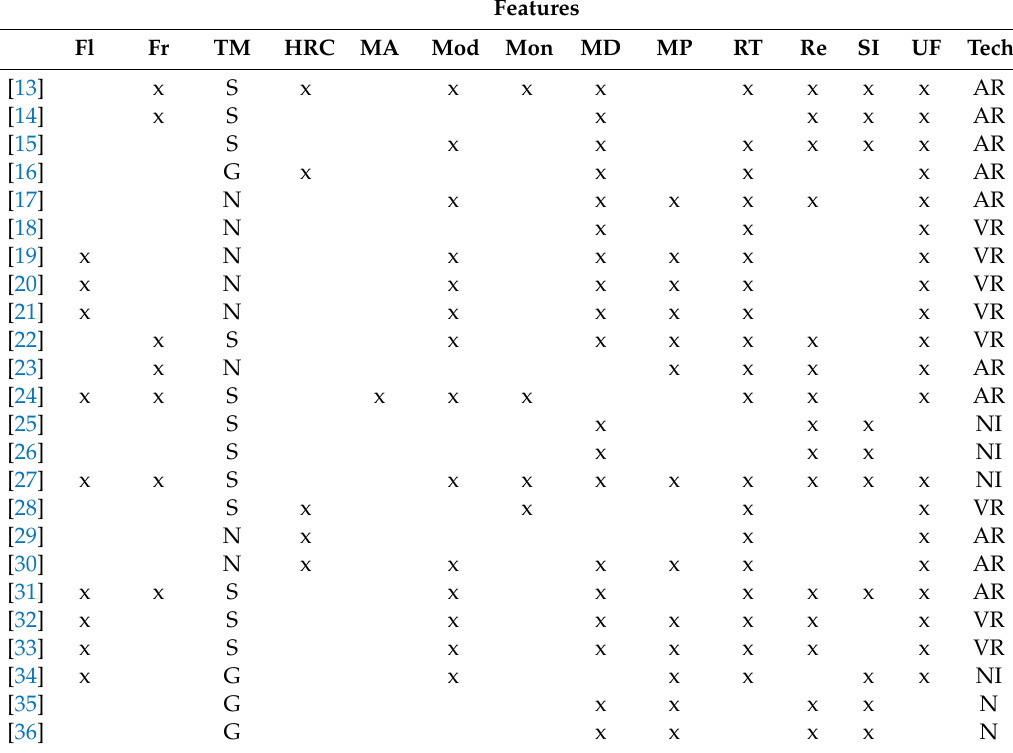
Table 1. This table presents a summary of the features considered and their presence in the works